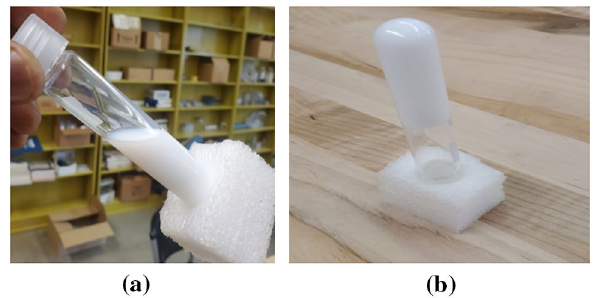
Fig. 2 Appearance of nano silica gel. a Before Gelation b After Gela-